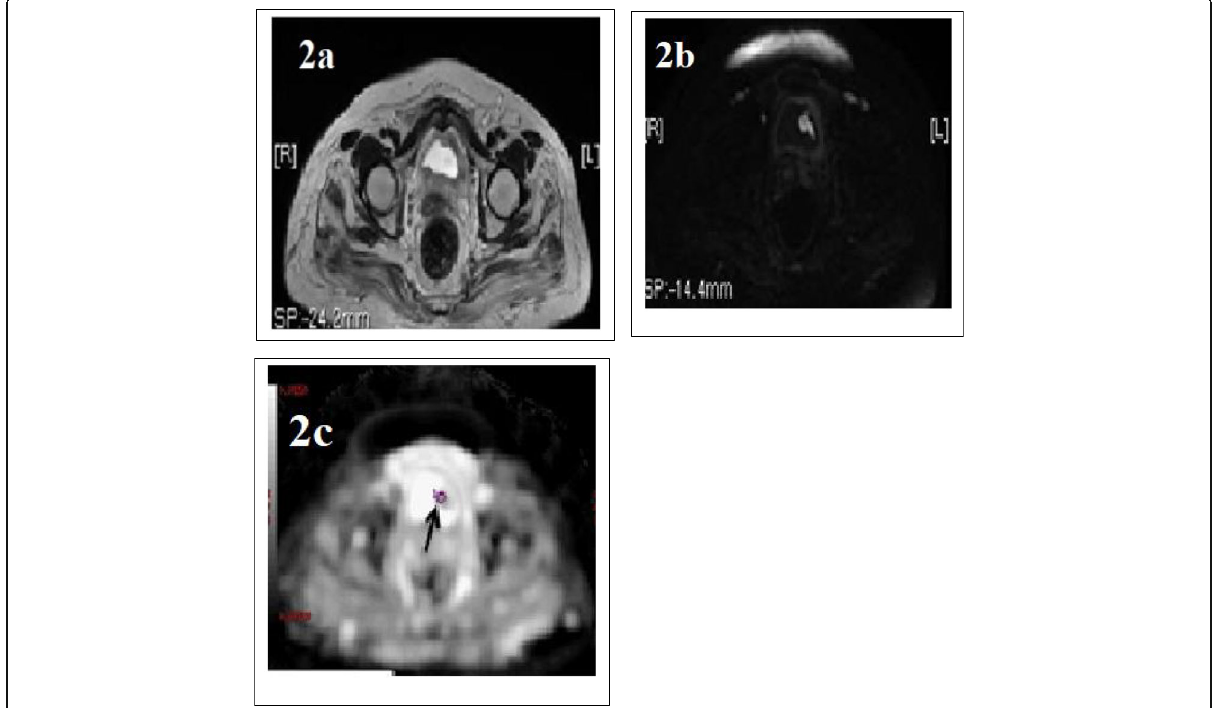
Fig. 2 Non-invasive papillary urothelial “ transitional ” cell carcinoma with free lamina propria and muscle layer, (stage T1, grade 1). a T2WI showing small sized mass lesion at the left anterolateral aspect of the urinary bladder wall with focal mural disruption (stage T2). b DWIs showing restricted diffusion of the lesion with no disruption (stage T1), matching with the pathological findings. c The mean ADC value = 1.87 × 10 − 3 mm 2